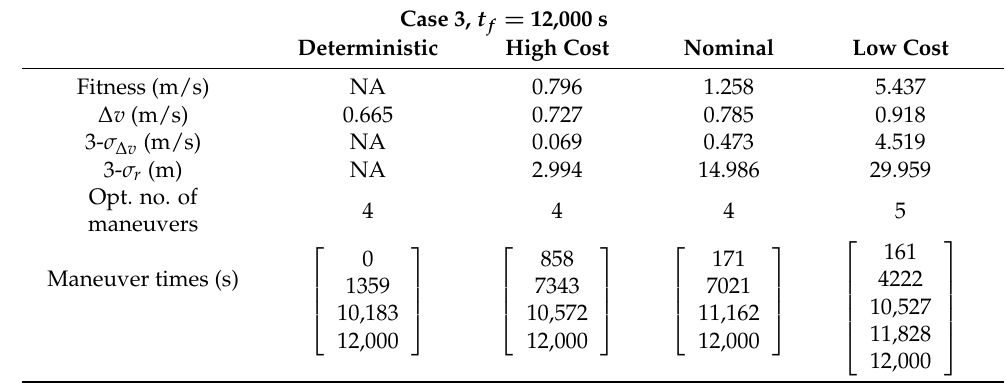
Table 5. Optimal trajectory results when t f = 12,000 s.